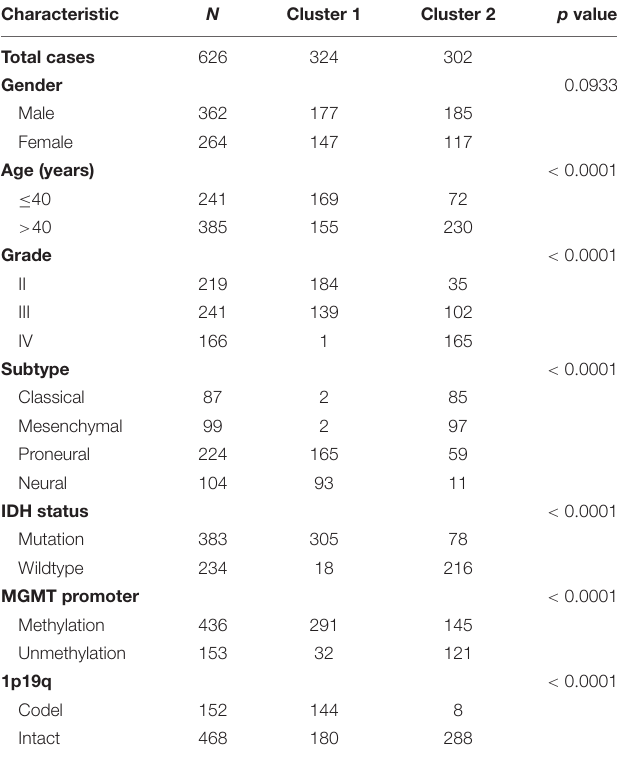
TABLE 1 | Characteristics of patients in cluster 1 and cluster 2 in TCGA